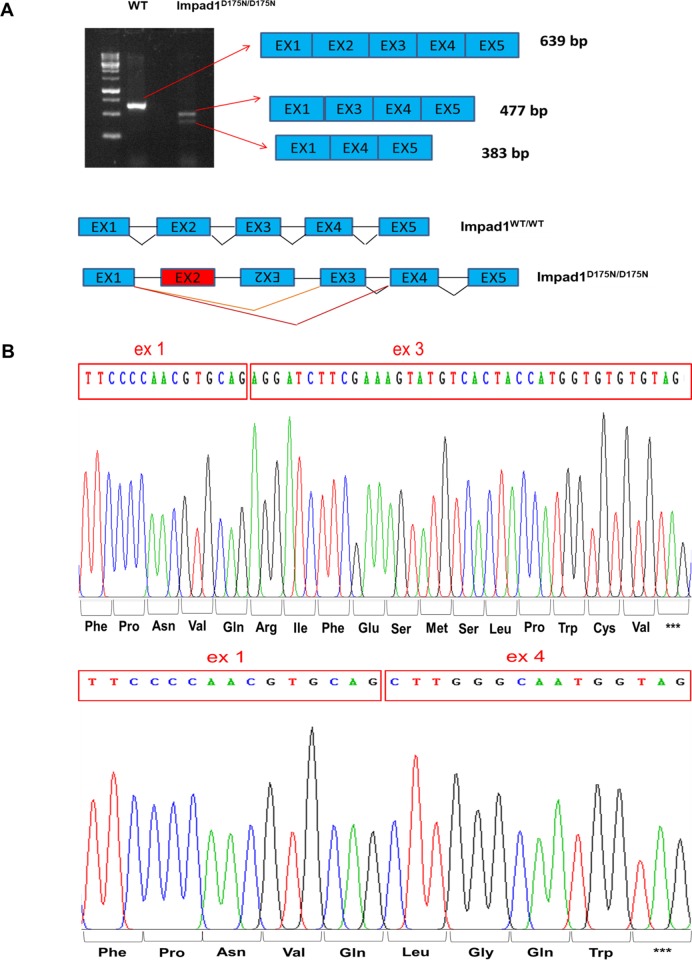
Alternative splicing analysis of Impad1 mRNA.(A) RT-PCR using primers Imp7 and Imp12 that amplify a region spanning exon 1 to exon 5 was performed from skin total RNA of wild-type and Impad1D175N/D175N newborn mice and analysed by 1.5% agarose gel. In wild-type animals one band, 639 bp long, corresponding to the correctly spliced Impad1 transcript including the 5 coding exons is present. This band is not detected in mutant mice, conversely two different bands, 477 bp and 383 bp long, respectively are observed. (B) Sequencing of the two bands demonstrates that the two transcript variants lack exon 2 or both exon 2 and exon 3.